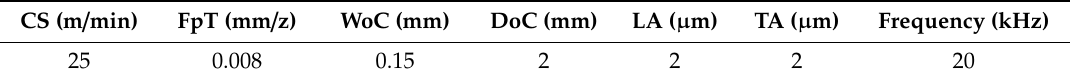
Table 5. Cutting and ultrasonic